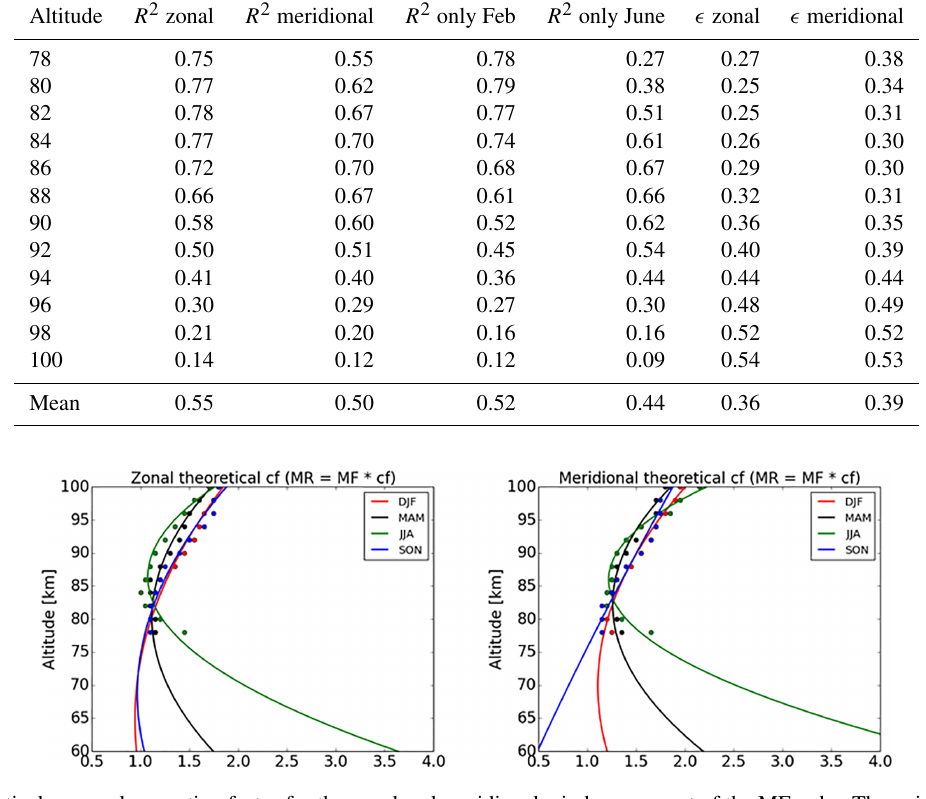
Figure 10. Theoretical seasonal correction factor for the zonal and meridional wind component of the MF radar. The points between 78 and 100km are based on a comparison between the two radars according to Fig. 11. The fitted curves are polynomial functions of second degree according to Table